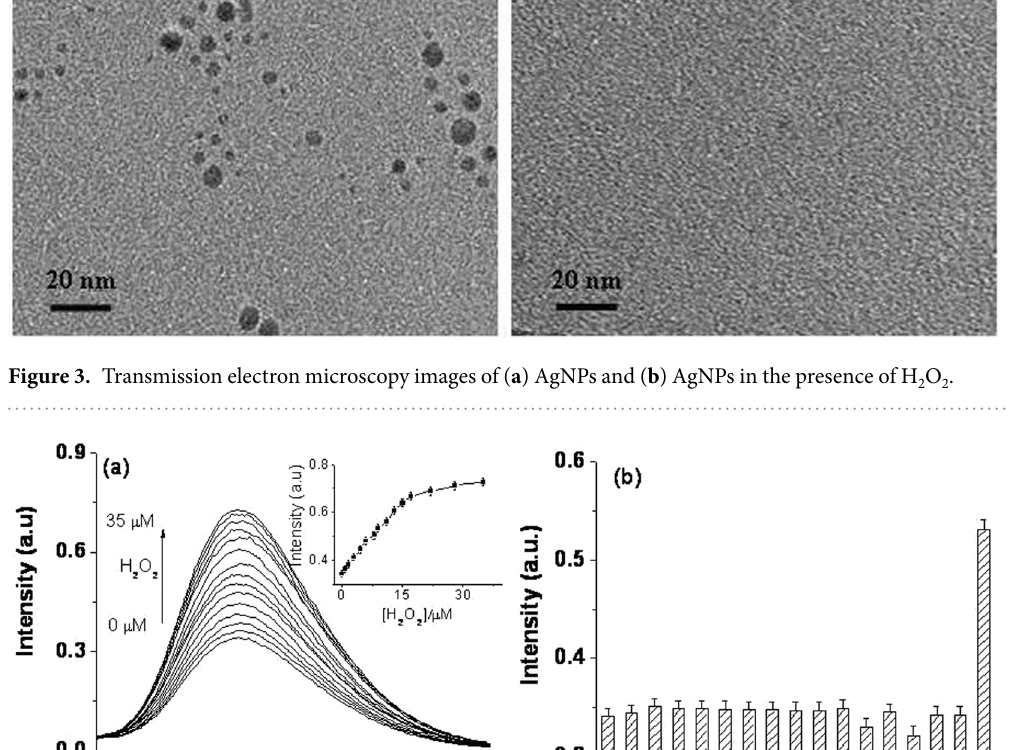
Fig. S4, the luminescence intensity of the Ir-1 –AgNP system increased with time and reached the plateau after 10 min, indicating that the reaction between AgNPs and H 2 O 2 at ambient temperature is rapid. In the absence of AgNPs, H 2 O 2 showed no apparent effect on the luminescence of Ir-1 (Fig. S5). Therefore, the increase in the luminescence of the system should arise primarily from the decomposition of AgNPs by H 2 O 2 , which restores the emission of Ir-1 . The mechanism involved in the luminescence quenching and recovery process was also demonstrated by transmission electron microscopy (TEM) imaging. In the absence of the Ir-1 , the AgNPs were well-dispersed (Fig. 3a). However, after the addition of Ir-1 , slight aggregation of AgNPs was observed, suggesting that Ir-1 and AgNPs interacted on the surface of AgNPs (Fig. S6b). The identity of the Ir-1 –AgNP complex was further con- firmed by energy dispersive X-ray spectroscopy (EDX), which showed strong elemental signals for both Ir and Ag (Fig. S6c). Strikingly, after treatment of AgNPs with H 2 O 2 , no AgNPs could be observed in the TEM images (Fig. 3b). This suggests that the AgNPs were decomposed and transformed to Ag + , which is consistent with pre- viously reported 36–38 . The UV–vis absorbance spectra of AgNPs in the absence and presence of H 2 O 2 are shown in Fig. S7. AgNPs alone showed a strong characteristic surface plasmon resonance peak at around 390 nm 39 . However, the absorption band of AgNPs gradually decreased upon increasing concentration of H 2 O 2 . These phe- nomena were ascribed to the oxidation of AgNPs to Ag + by H 2 O 2 , leading the decomposition of the AgNPs. Sensitivity.